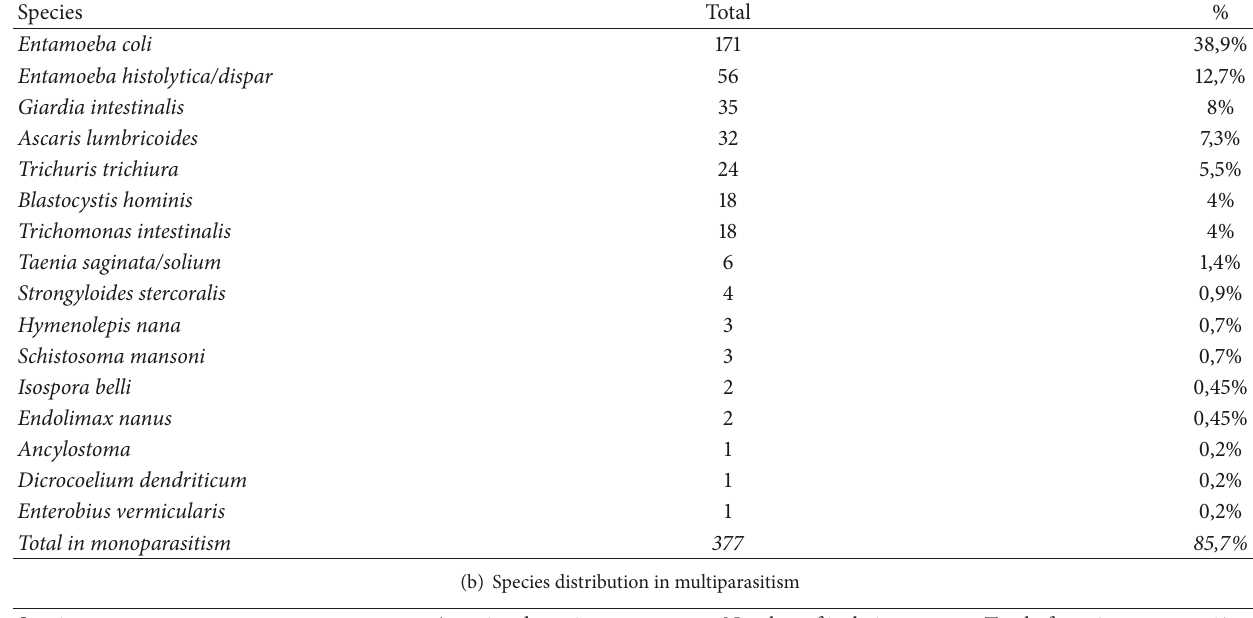
Table 2 (a) Species distribution in